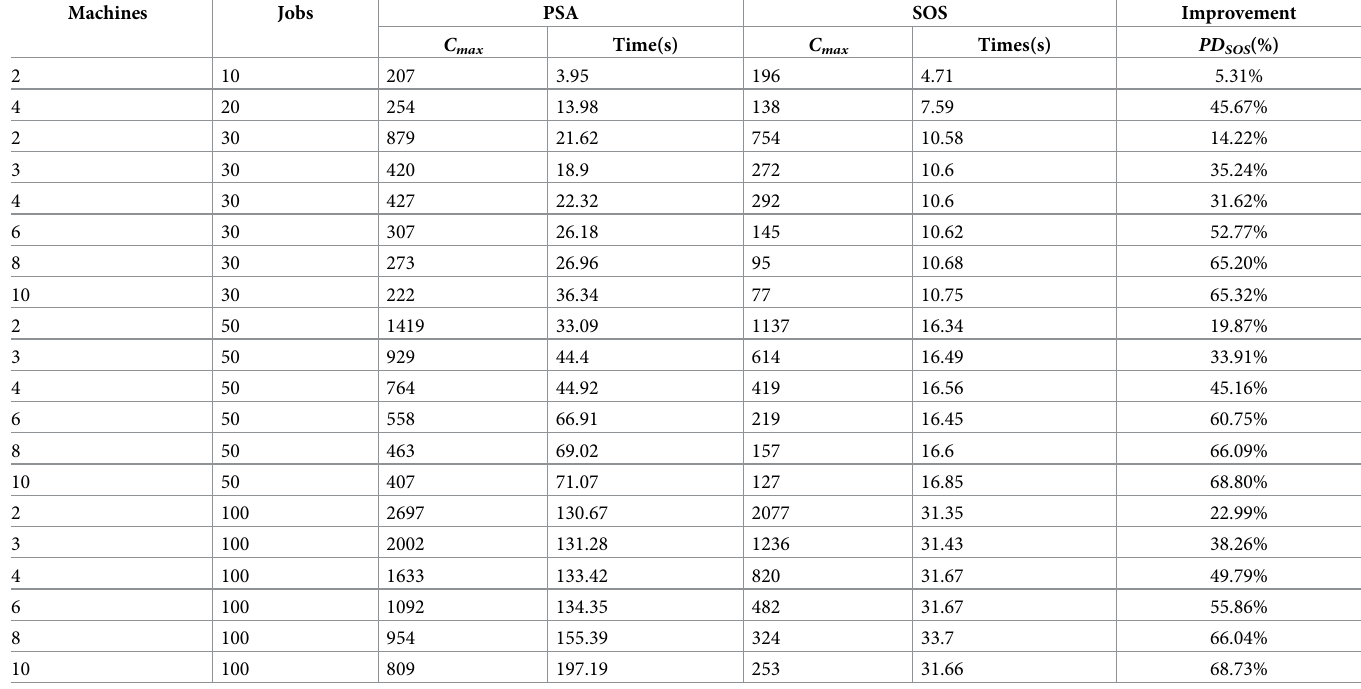
Table 3. Comparison between SOS and SA, with SOS as the reference